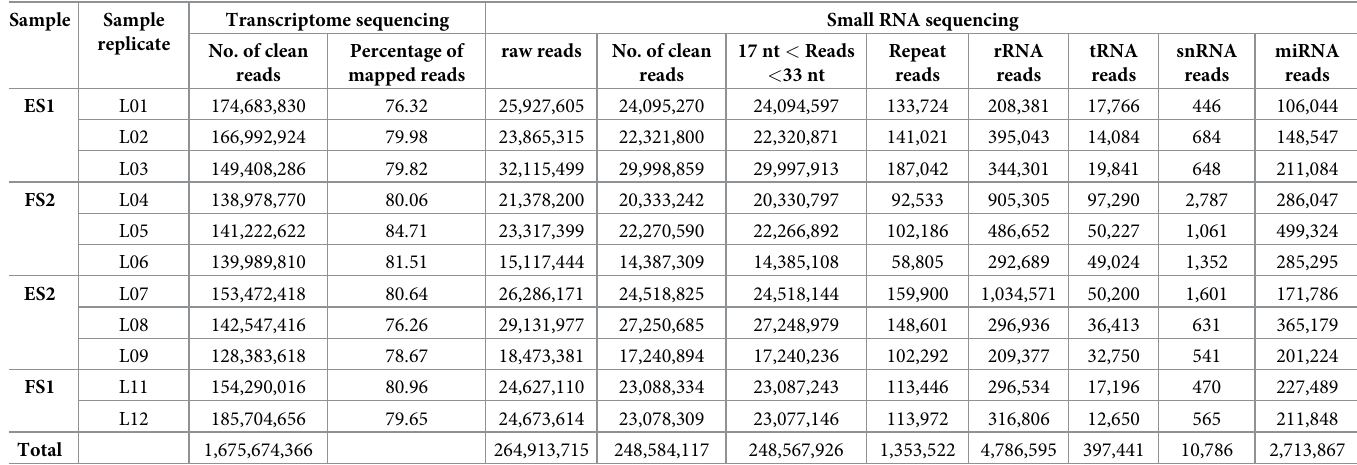
Table 1. Summary of transcriptome and small RNA sequencing data. Sample